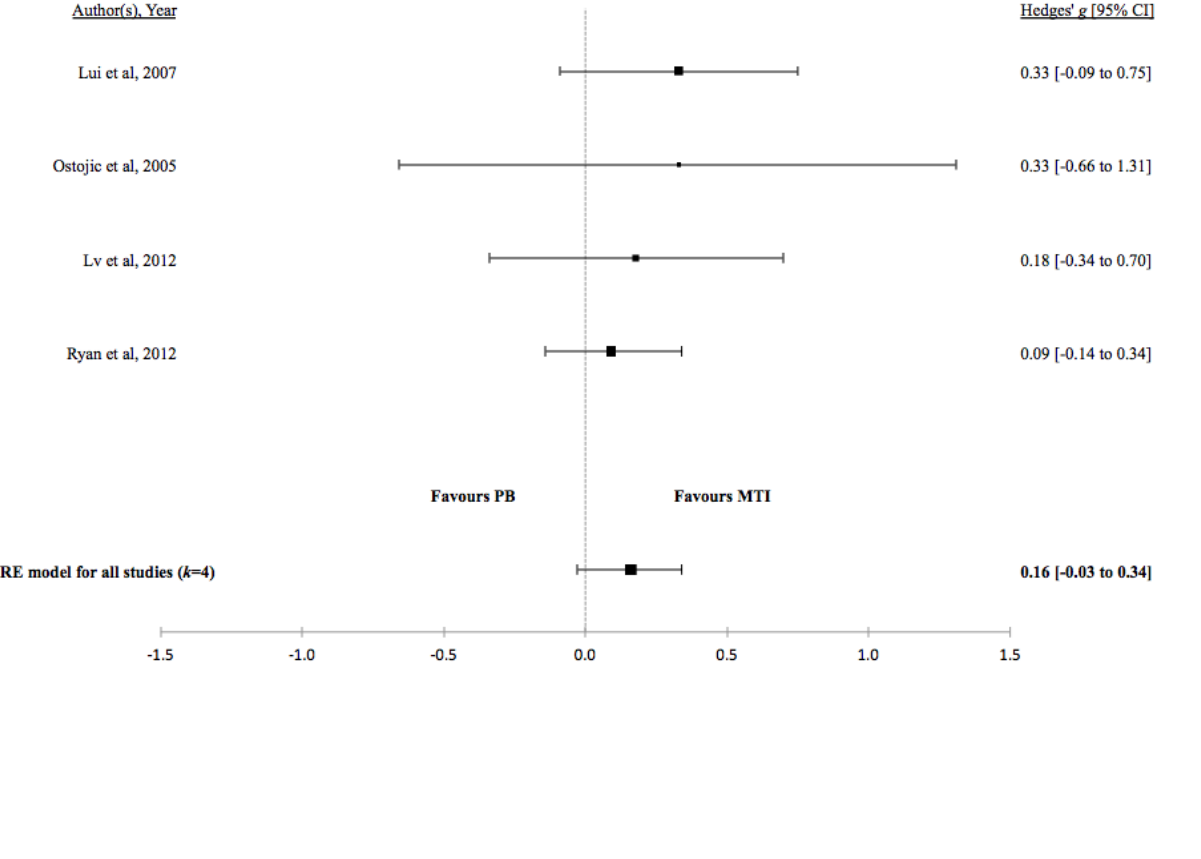
Figure 4. Forest plot of the standardized mean difference in medication adherence between MTI and Paper-based group (PB). MTI: mobile technology